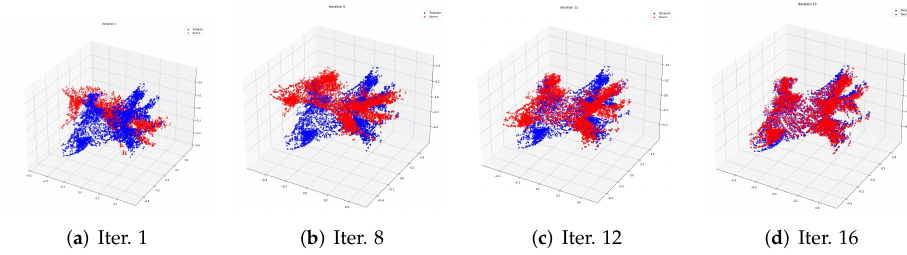
Figure 2. The process of registration in one training data item with patient Id 52997 from the 1st to the 16th iteration. The red point data represent the sources of the process, while the blue represent the